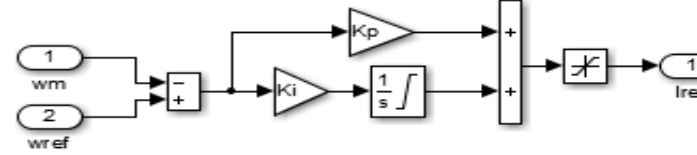
Figure 9. Simulink model of PID controller.